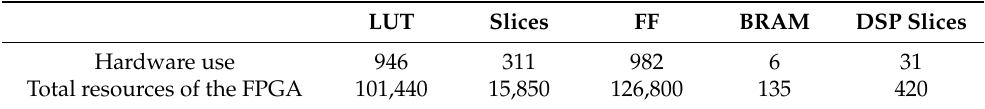
Table 3. Hardware used on FPGA.